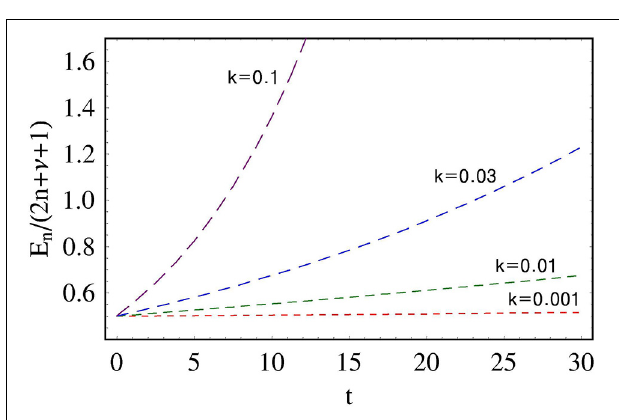
FIGURE 2 | Time evolution of the radial energy expectation values divided by (2 n + ν + 1) with the choice of B ( t ) as Equation (35). The values we used are ¯ h = 1, m = 1, q = 1, and B 0 = 1. All these values are taken to be dimensionless for